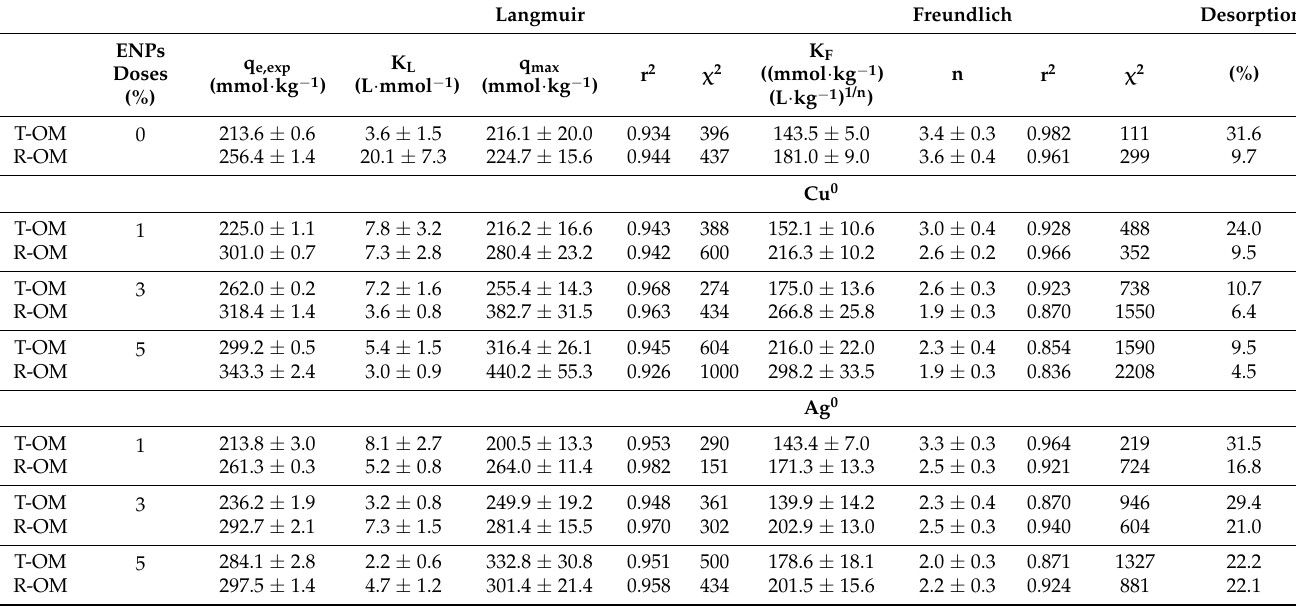
Table 6. Langmuir and Freundlich parameters ( ± standard error) obtained from H 2 PO 4 − adsorption isotherms at pH 5.5 ± 0.2 and desorption (%) for the soil with total organic matter (T-OM) and with partial removal of organic matter (R-OM) in the absence and presence of different doses of Cu 0 or Ag 0 ENPs. Table 4. pH changes associated to H 2 PO 4 − adsorption in the absence and presence of different doses of Cu 0 or Ag 0 ENPs and two levels of soil organic matter content (total organic matter, T-OM and Langmuir Freundlich Desorption ENPs